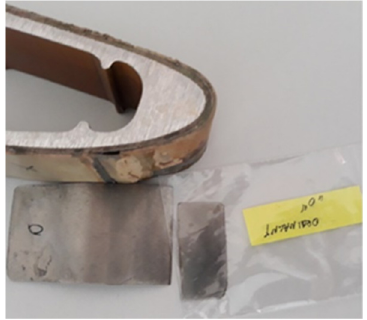
Figure 4. Sample of a shield for the XRF identification tests. Table 1. XRF-identified composition of the sheath material.